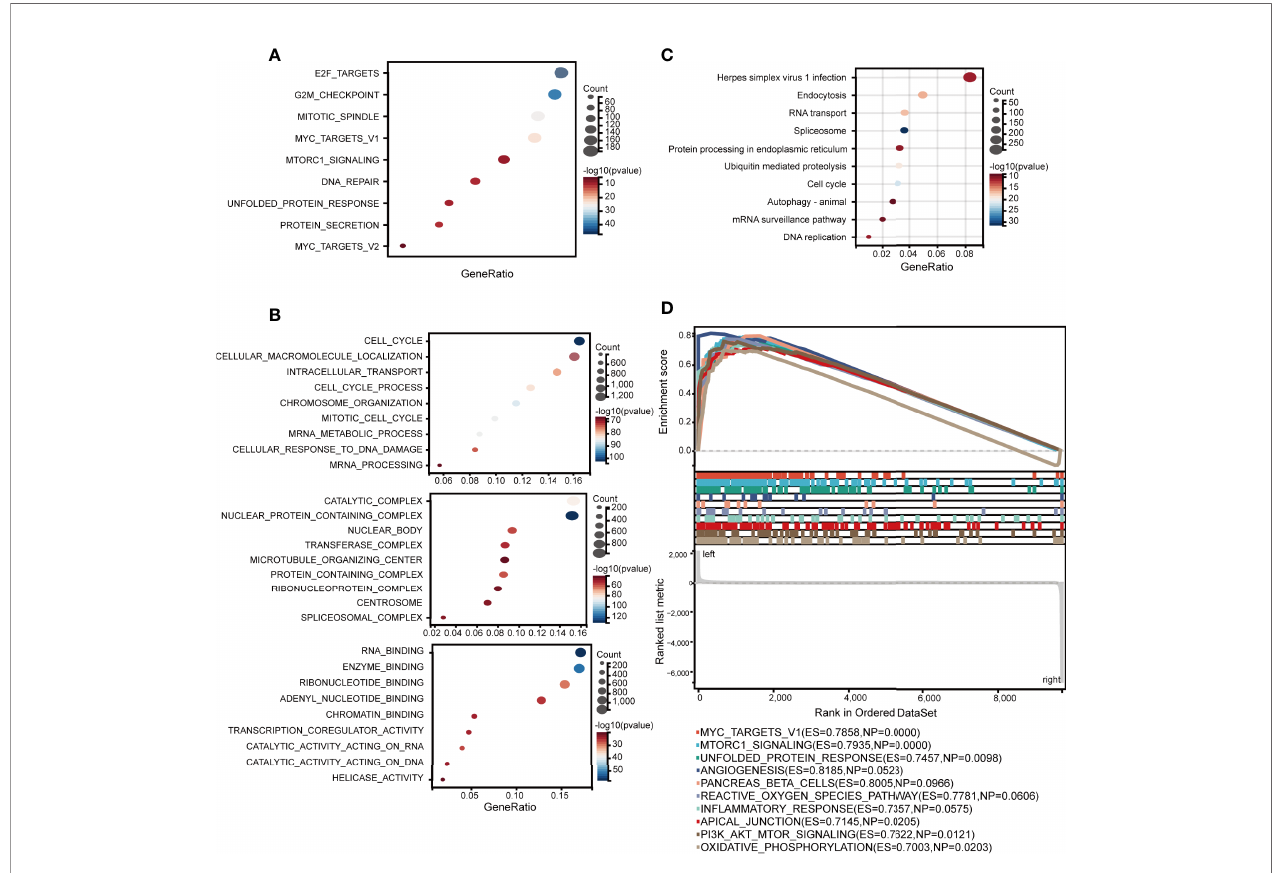
FIGURE 6 | Associations between ELOVL1 and immune-related pathways. (A) Immune-related over-representation analysis. (B) Gene set enrichment analysis based on immune-related KEGG database; (C) Immune-related biological processes. (D) Immune-related molecular